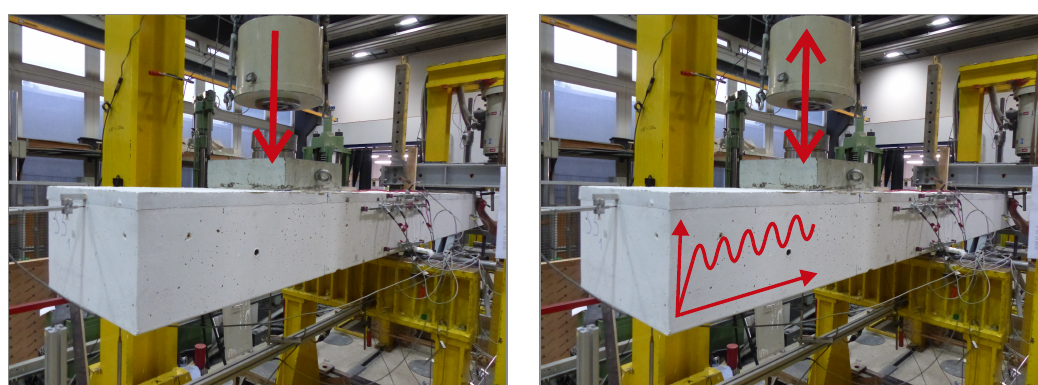
Figure 4. Overview of the experimental programme (photographs by IMB, RWTH Aachen University). The quadratic textile reinforcement meshes were provided by the project partner solidian. The mesh size (centre-to-centre distance of the fibre strands) was either 21 or 38 mm. Depending on the knitting method, di ff erent bond properties can occur which not only di ff er among the various grids but also depend on the direction [38] since weft and warp vary in cross-sectional shape and surface characteristics (Figure